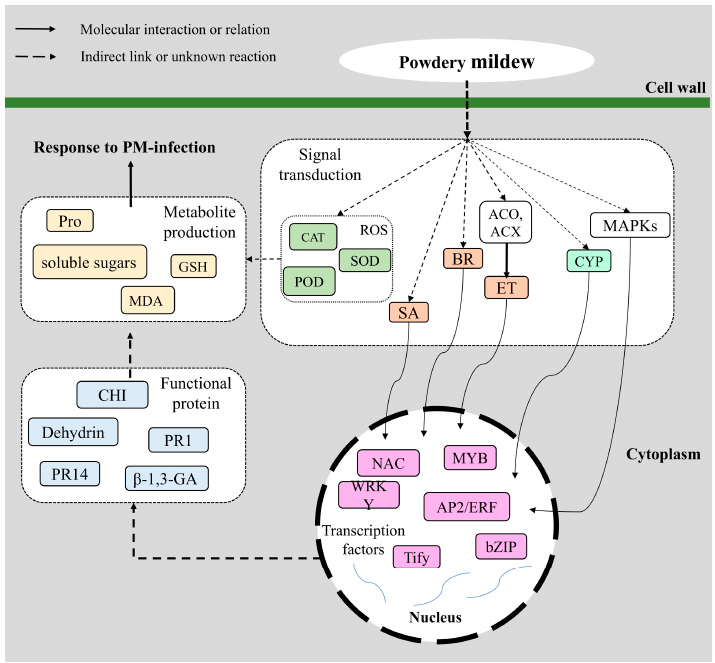
Figure 7. Molecular network underlying the defense response to powdery mildew (PM) in apple leaves.